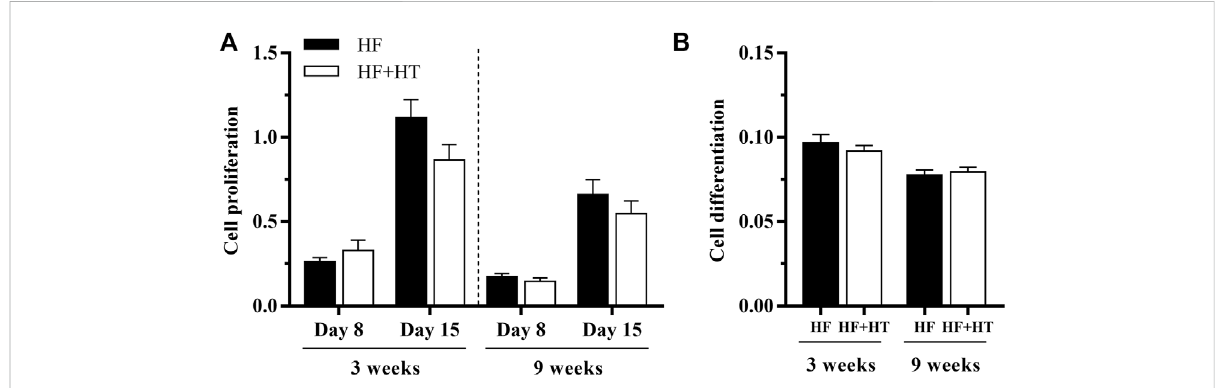
FIGURE 6 (A) Proliferation and (B) differentiation of bone-derived cells at days 8 and 15, or 20 respectively, of culture development, extracted from gilthead sea bream juveniles fed with a high-fat diet in the absence (HF) or presence (HF + HT) of hydroxytyrosol (0.52 g HT/kg feed), at a standard ration (3% biomass/tank) for 3 and 9 weeks. Data are shown as Mean + SEM ( n = 8). No differences were observed between diets, assessed by student-unpaired t -tests ( p <